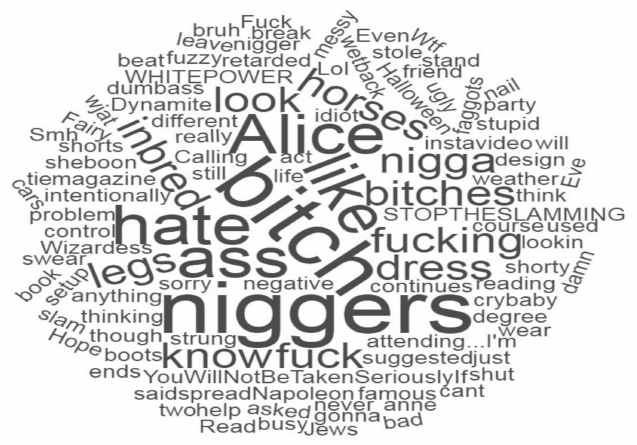
Figure 9. Tweet cloud generated from the tweets of a cyber-bullying